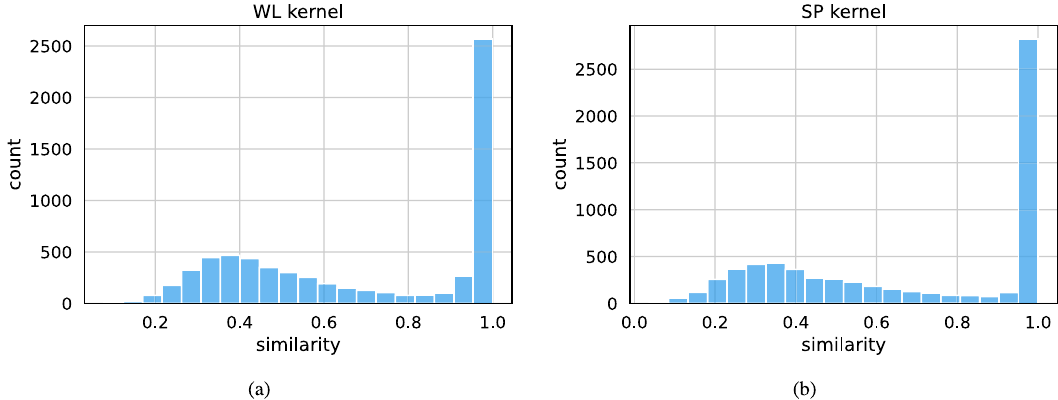
Fig. 3 Histograms of similarities between input and reconstructed trajectories. Each input trajectory was compared against its corresponding reconstructed trajectory using a graph kernel. a Histogram of similarities between input graphs and reconstructed graphs using the Weisfeiler-Lehman subtree (WL) kernel. b Histogram of similarities between input graphs and reconstructed graphs using the shortest path (SP) kernel.